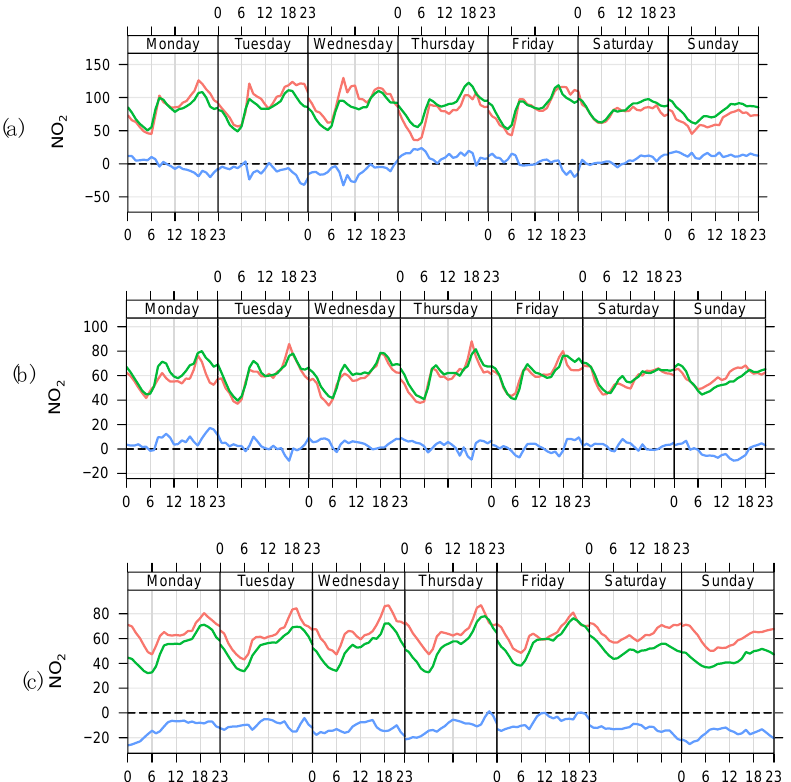
Figure A3. Temporal variations in NO 2 ( µ g/m3) for Besiktas Station with three Phases: ( a ) Phase I differences, Before: 30.6.2015-11.3.2016 (Red), A fter: 12.3.2016-30.6.2017 (G reen), A fter-Before (Blue); (b) Phase II differences, Before: 30.6.2017-11.3.2018 (R ed), A fter: 12.3.2018-30.6.2019 (G reen), A fter- Before (Blue); (c) Phase III differences, Before: 30.6.2019-11.3.2020 (Red), A fter: 12.3.2020-30.6.2021 (G reen), A fter-Before (Blue).